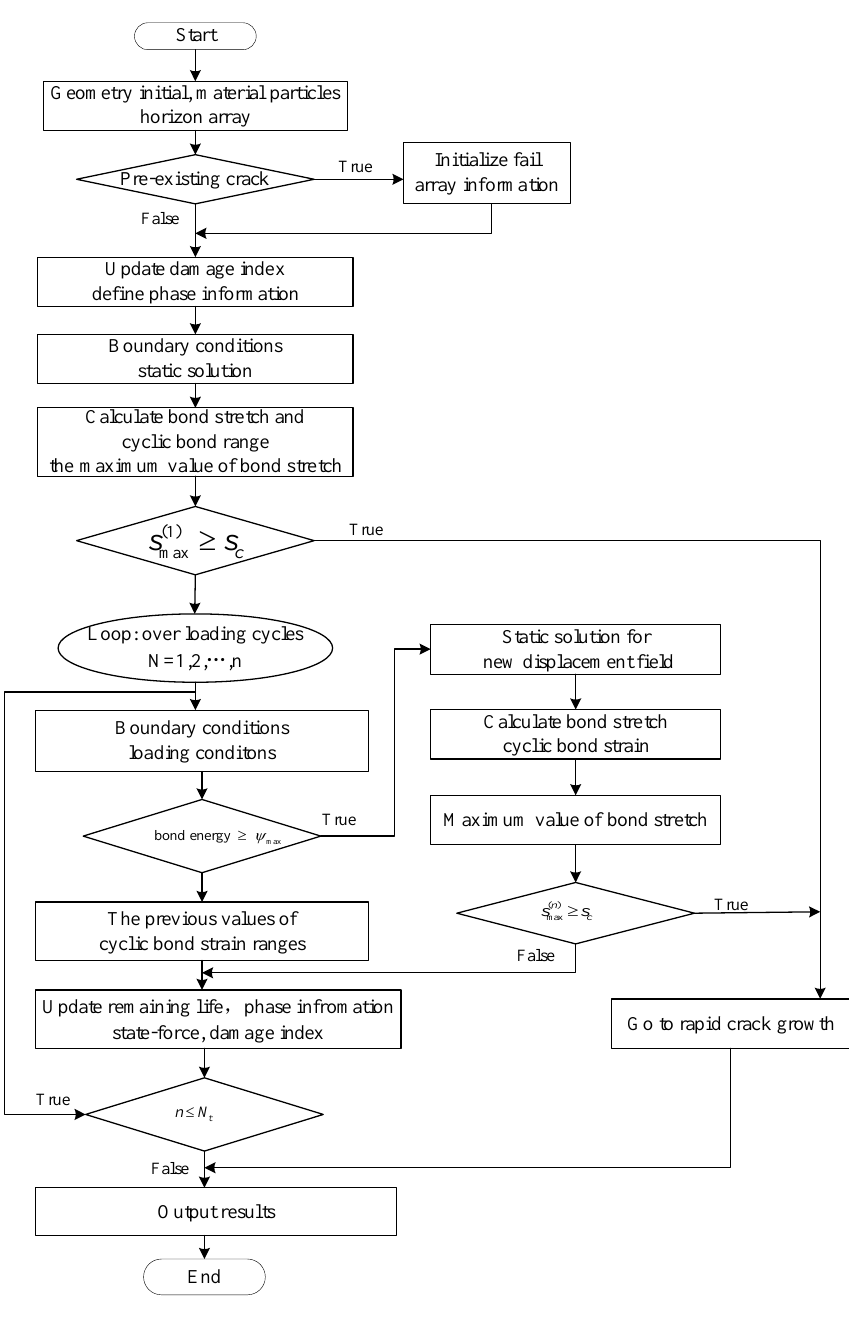
Figure 12. Follow chart of bending crack simulation.